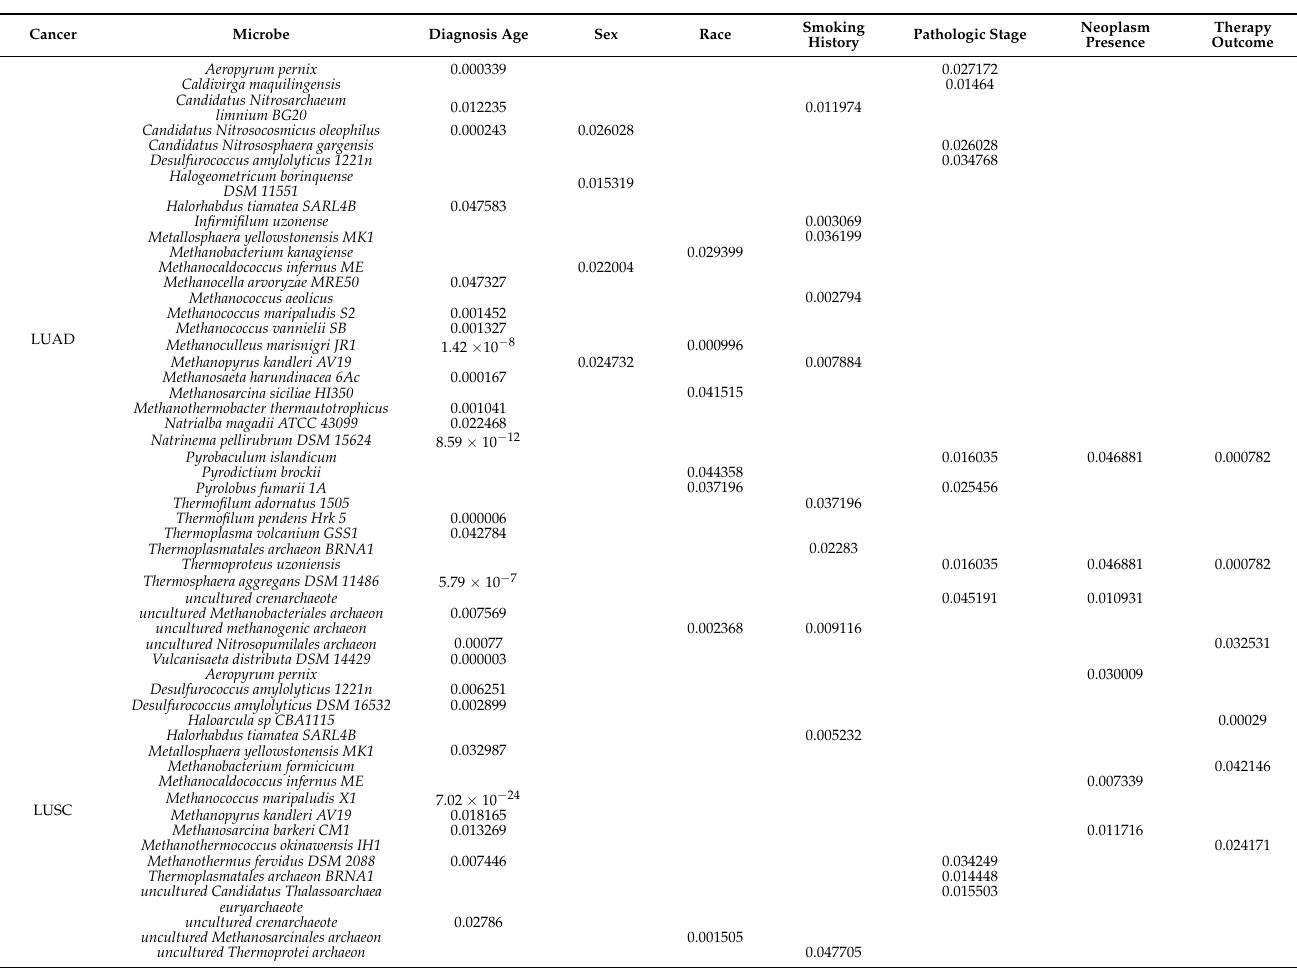
Table 2. List of microbes differentially abundant across LUAD and LUSC samples. Corresponding p -Value denoting significance of